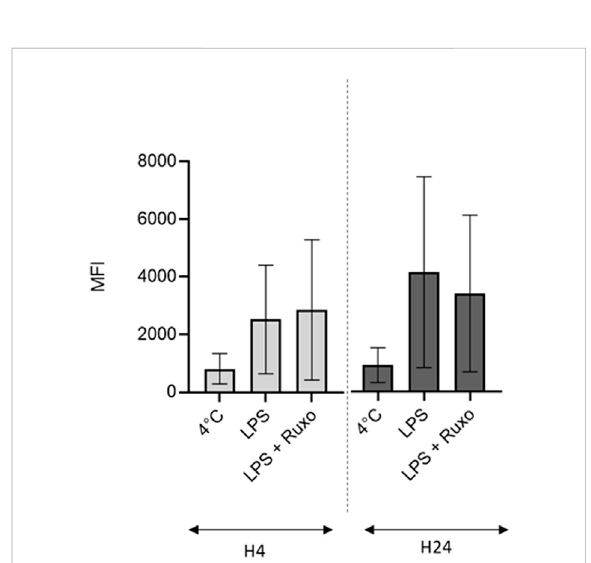
FIGURE 3 Ruxolitinib ’ s effect on the phagocytic activity of LMs. The day after isolation, LMs were treated with ruxolitinib (10 – 5 M) in the presenceofLPS(10 ng/ml)for4and24 h,beforebeingexposedto fl uorescent,opsonized E.coli bioparticles(10bioparticlesper LM). The intensity of intracellular fl uorescence after exposure to ruxolitinib was compared with those for LMs stimulated with LPS alone (positive control) and for LMs incubated at 4 ° C (negative control). The results of three independent experiments are represented graphically as median (bar) and range. MFI: mean fl uorescence intensity. Number of events was on average 6,653 ±